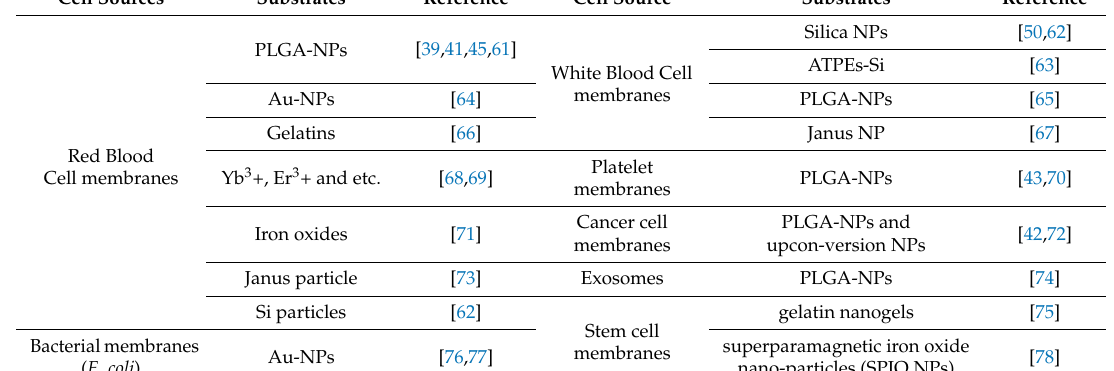
Table 1. A summary of the current uses of cell membranes.